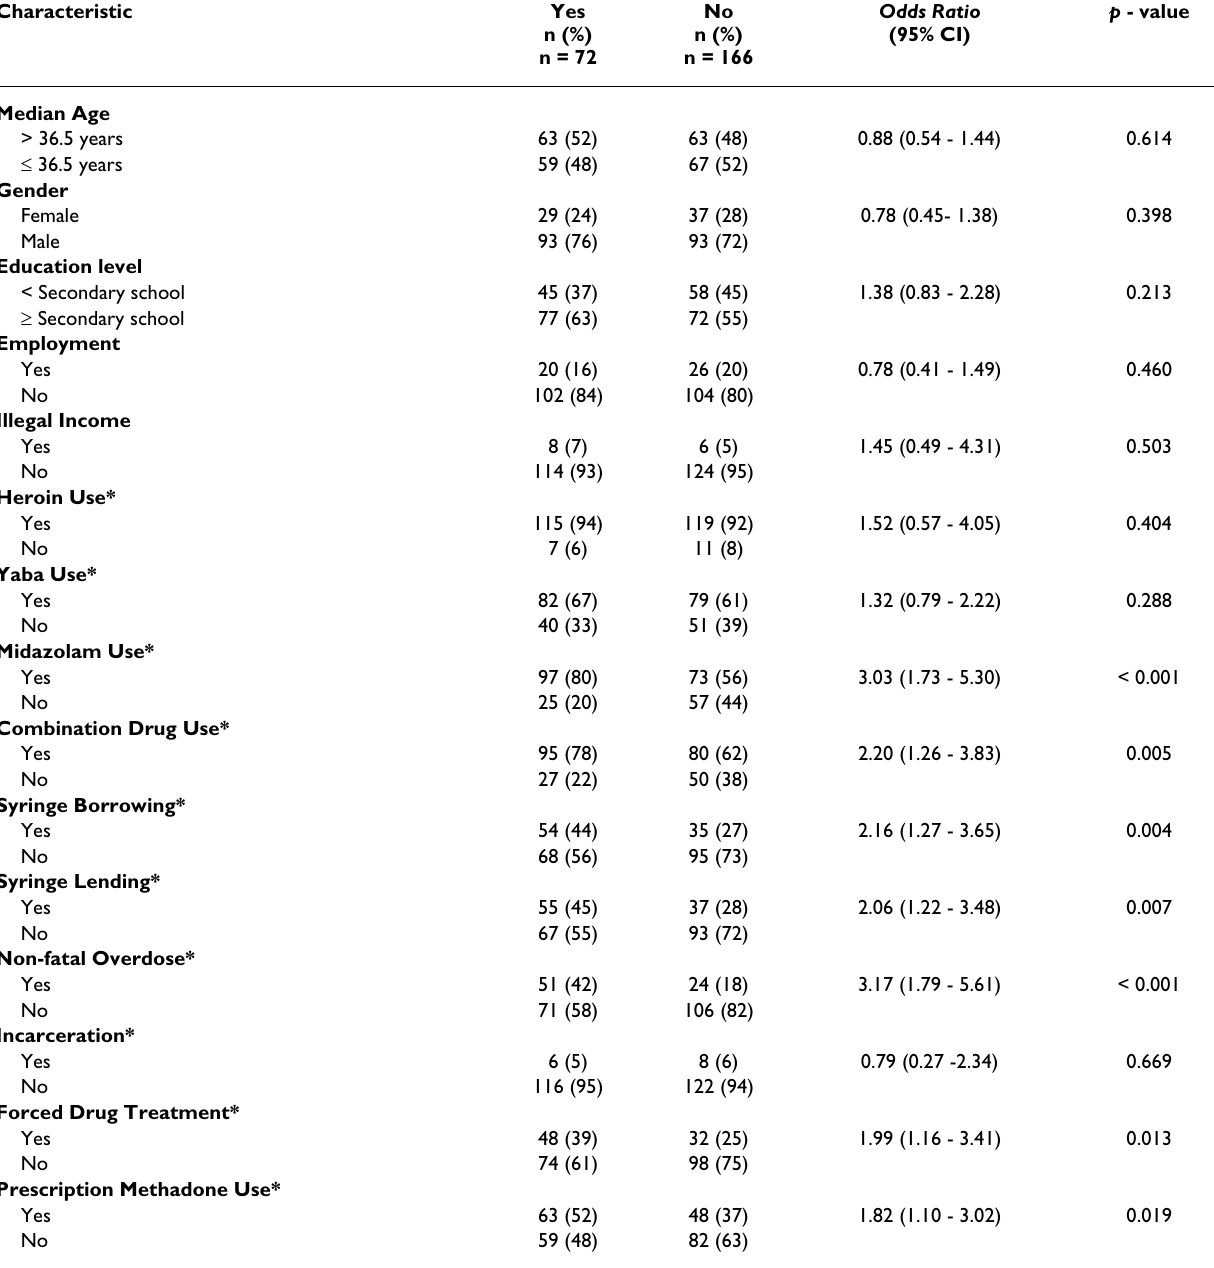
Table 1: Factors associated with drug planting by police among Thai injection drug users (N = 238)*